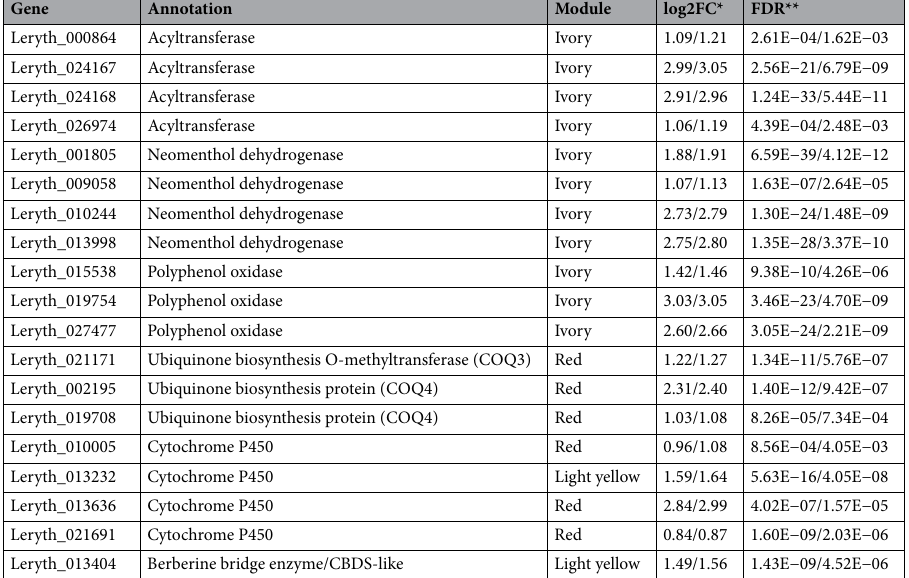
Table 1. Candidate genes of alkannin/shikonin (A/S) biosynthesis in Lithospermum officinale . Genes were identified by weighted gene coexpression network analysis. Expression of candidate genes in plants treated with methyl jasmonate (MeJA) is presented here with respect to control. *log2FC = log2 fold change, values above and below the/are from DESeq2 and edgeR, respectively. **FDR = False discovery rate, values above and below the/are from DESeq2 and edgeR,